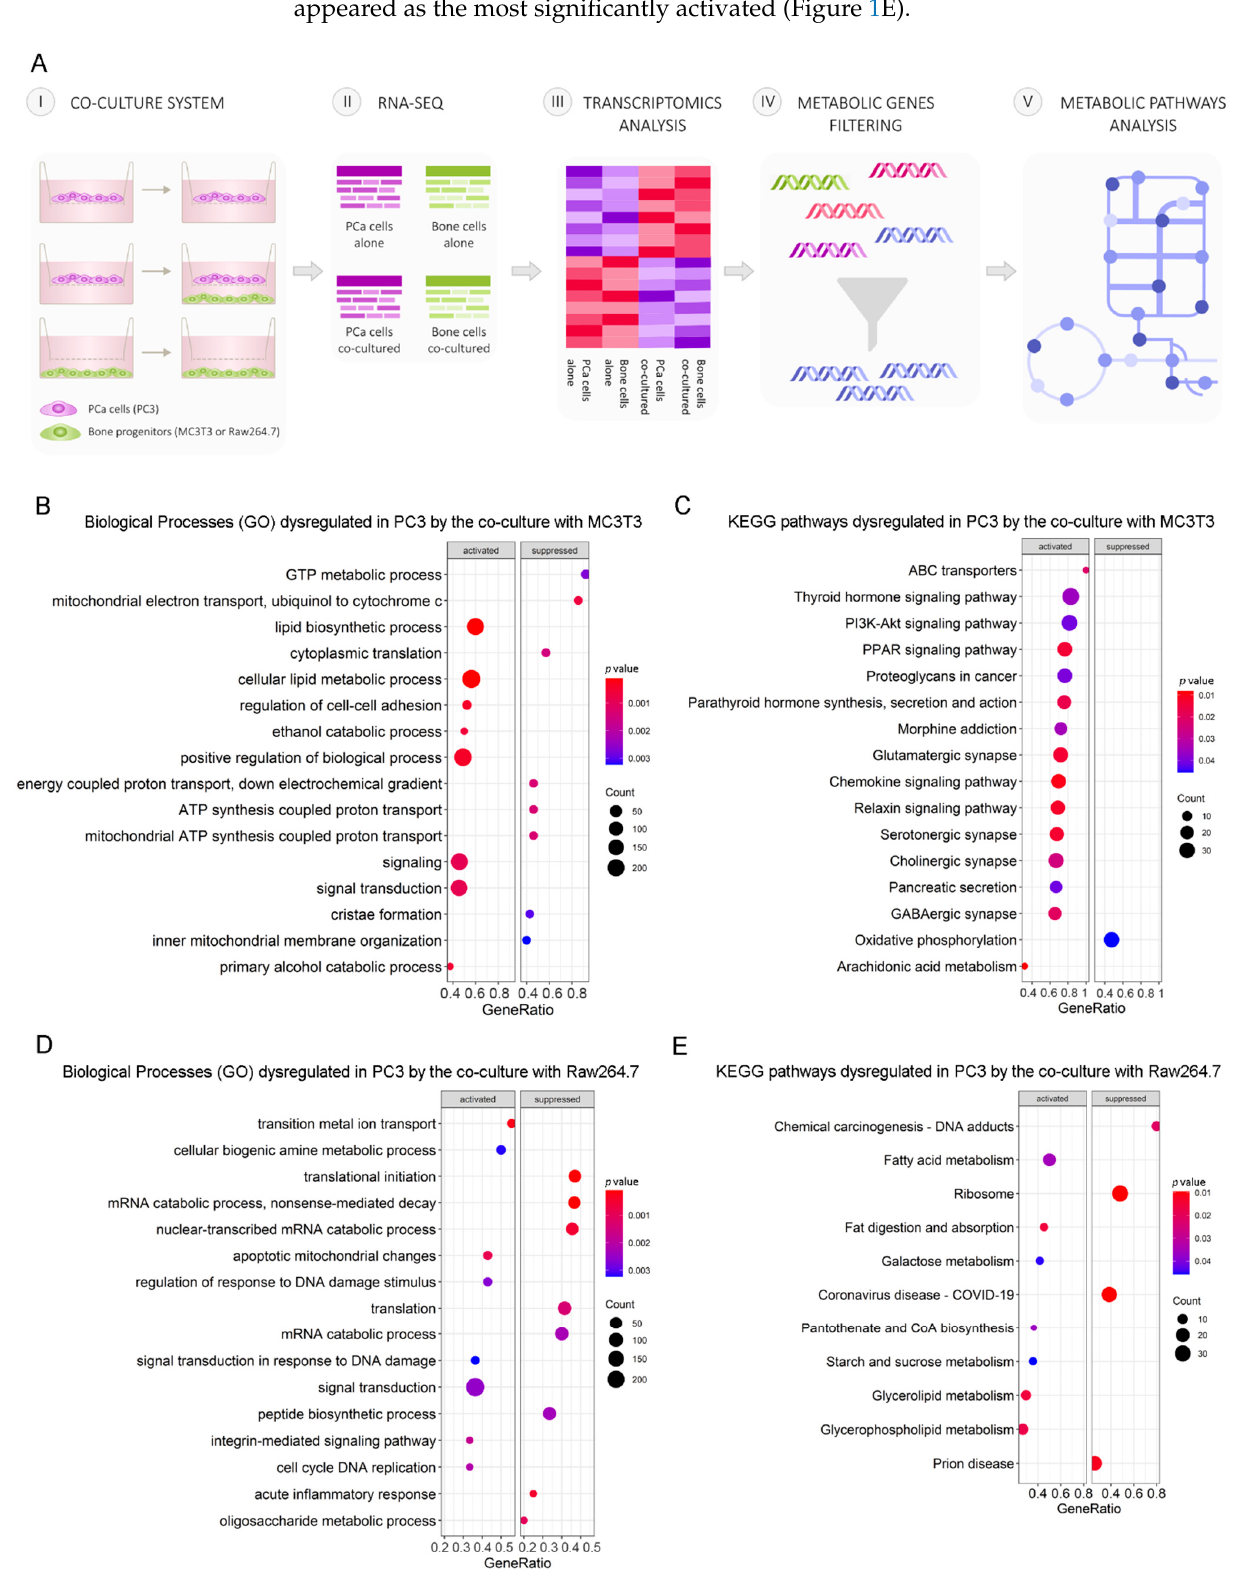
Figure 1. Schematic representation of the indirect co-culture system and alterations of tumor cells’ metabolic profile induced by the co-culture with bone progenitors. ( A ) PC3 cells were cultured alone